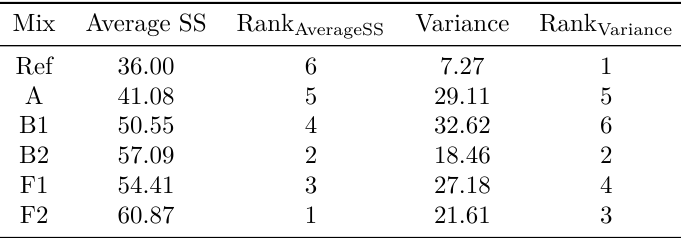
Table 8. Descriptive statistics of uncertainty analysis for each concrete